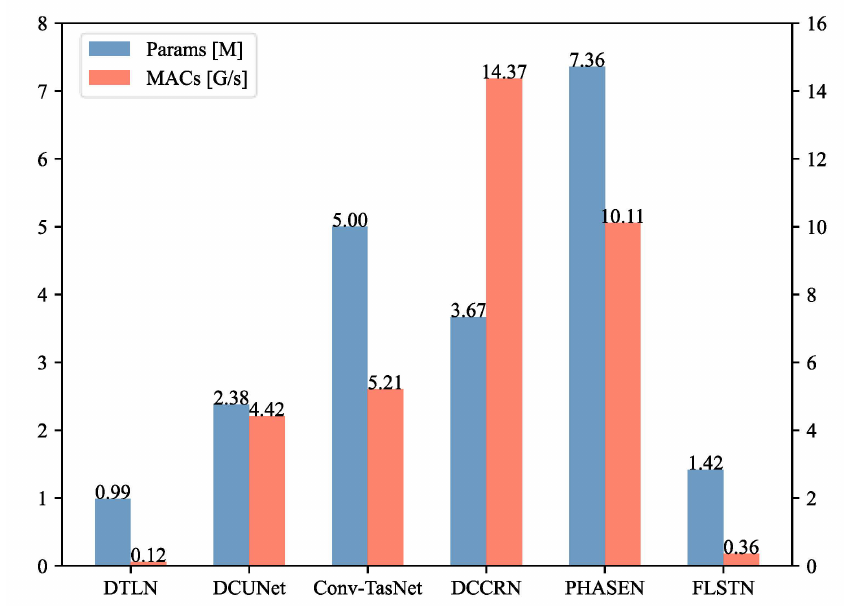
Figure 5. Complexity comparison with various competing network